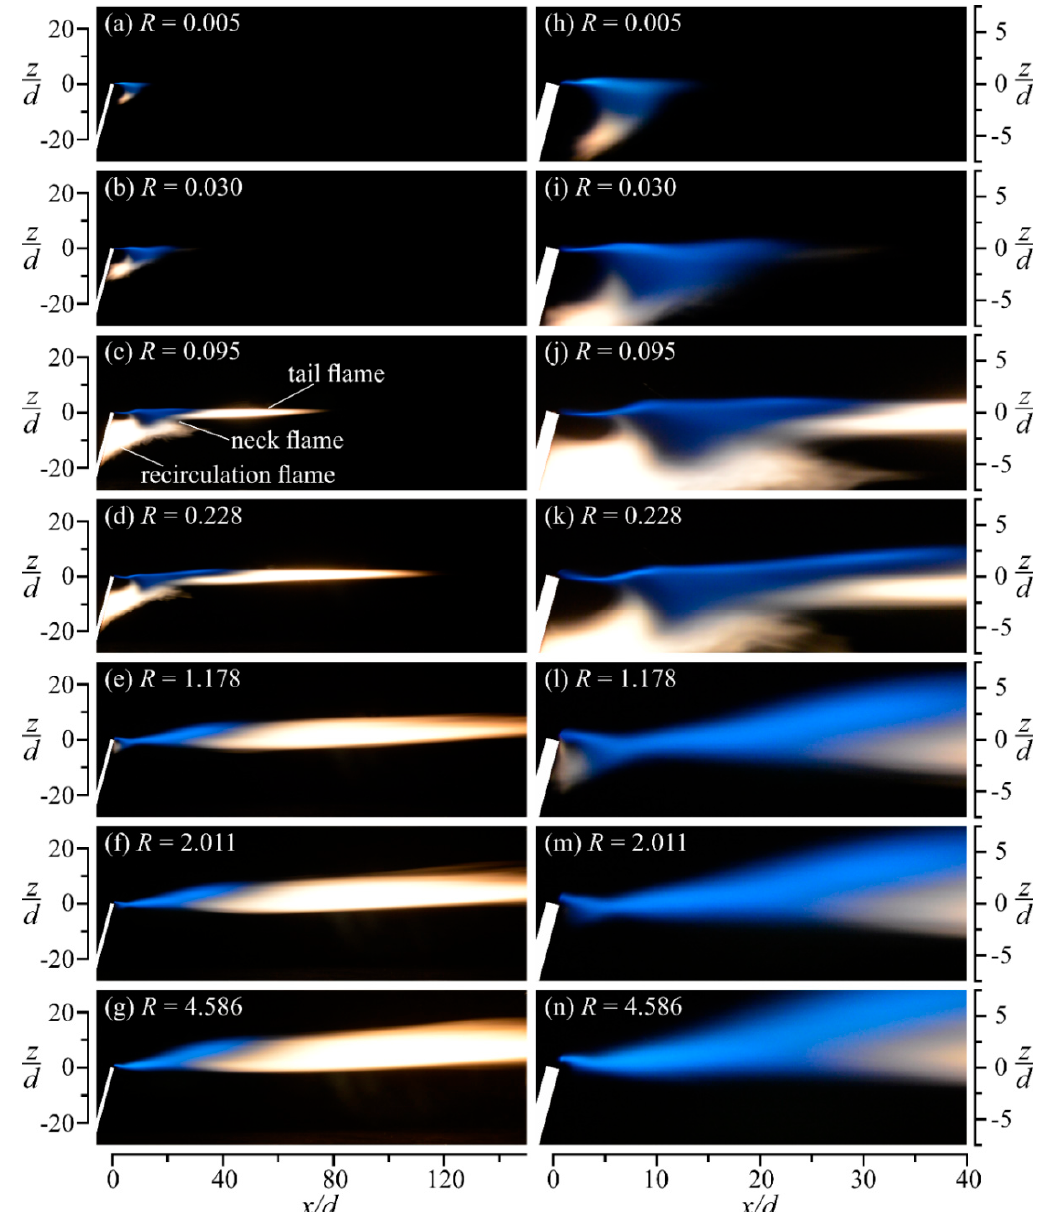
Figure 2 . Flame appearances from side view. Left column: Direct shot; right column: Close-up. Exposure time = 2 s. θ = 15 ◦